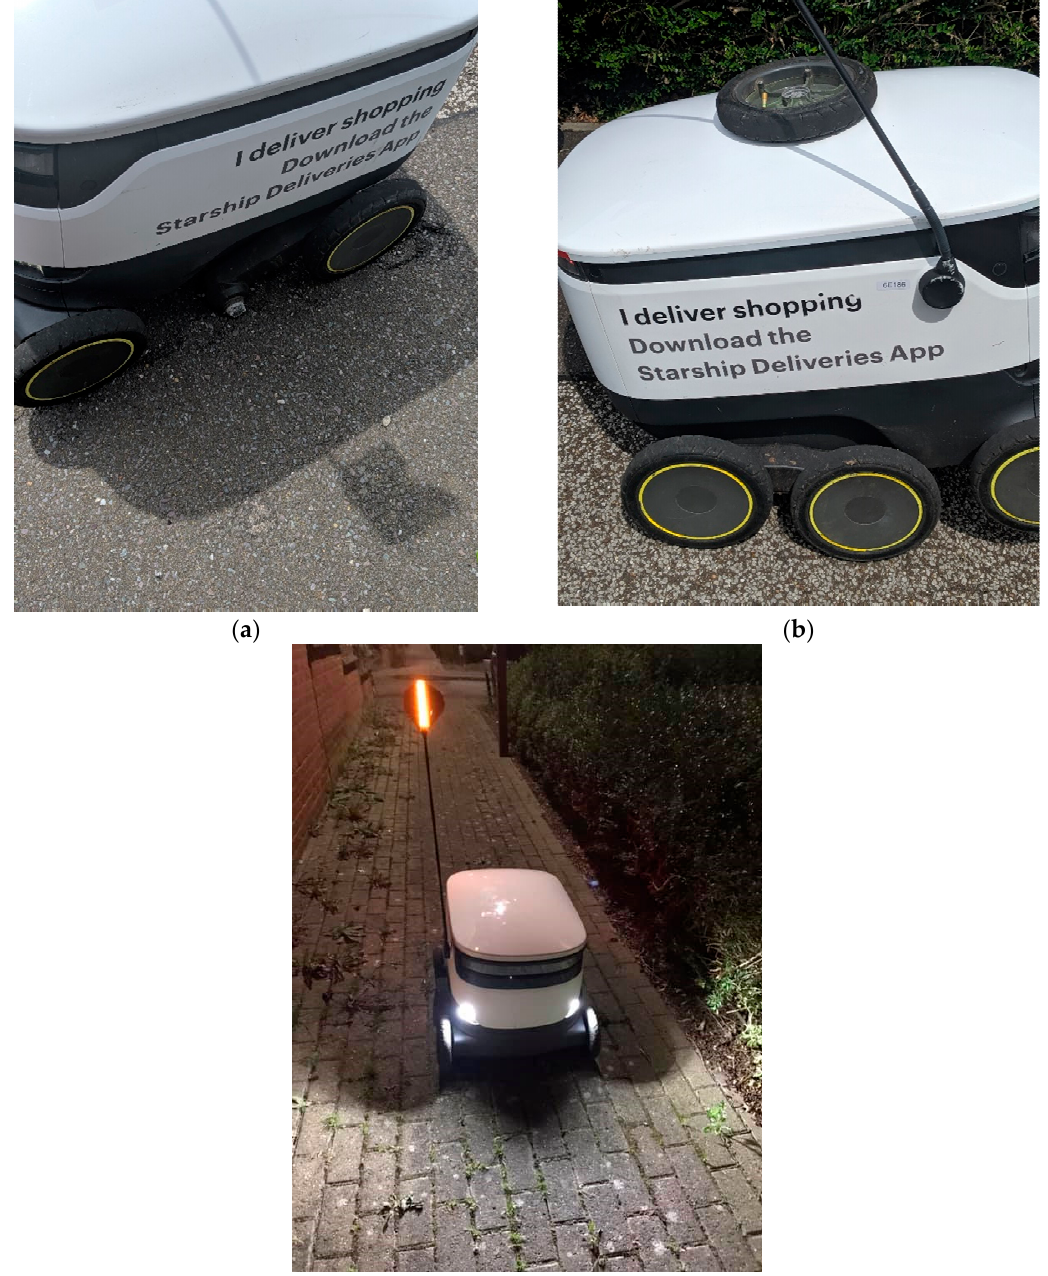
Figure 14. ( a , b ) The delivery Robot without a wheel. Photographs taken and Permission granted by Marston. ( c ) The delivery Robot in the evening with lights and identifiers. Photograph taken and Permission granted by Woodford.